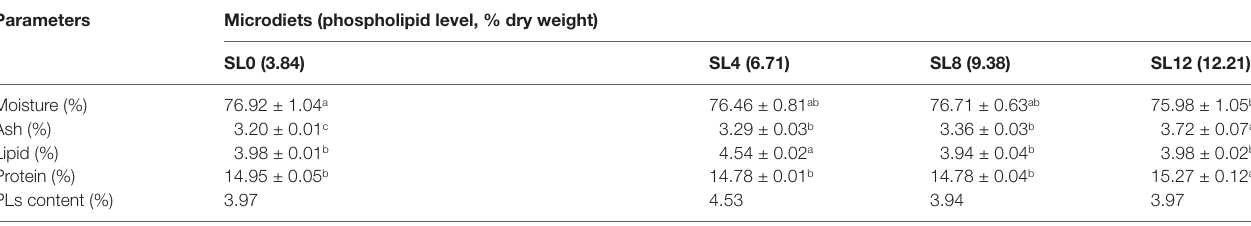
TABLE 4 | Larval body proximate composition of 55-dph rock bream larvae.